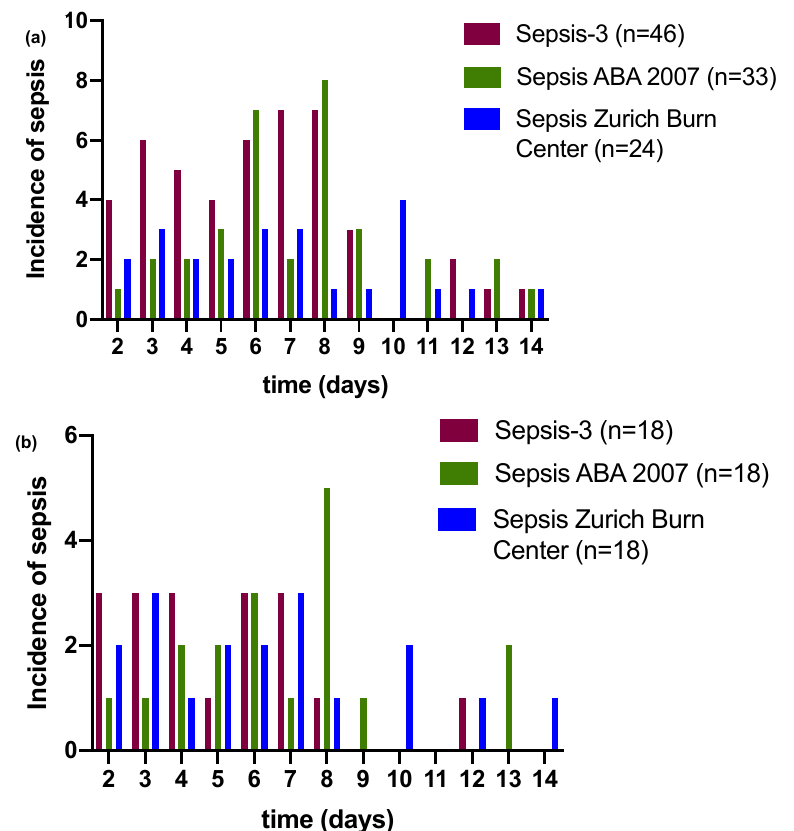
Figure 2. ( a ) Number of patients diagnosed with sepsis by the three definitions on a time scale across 14 days. The average (median) day of sepsis detection was 6 (interquartile range (IQR) 4) in Sepsis-3, 7 (IQR 3) in Sepsis ABA 2007, and 6.5 (IQR 6.0) in Sepsis Zurich Burn Center. ( b ) Sepsis incidence of the common overlap of septic patients across all three definitions ( n = 18).